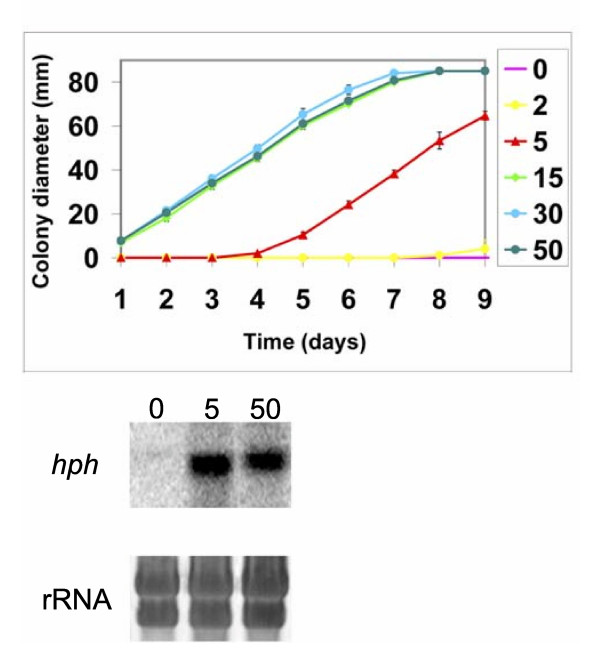
Effects of doxycycline on hygromycin sensitivity of a strain expressing rtTA in conjunction with the tetO7-hph reporter gene. Ten thousand conidia were spotted onto the center of a plate containing 750 μg/ml hygromycin and the indicated concentrations of doxycycline (μg/ml) and colony diameter was measured with time. Below: levels of hph RNA levels in the rtTA transformant by Northern blot analysis. Total RNA isolated from overnight cultures grown in the presence of 0, 5 or 50 μg/ml of doxycycline was fractionated by agarose gel electrophoresis, transferred to nylon membranes, and probed with a 32P-labeled hph probe.